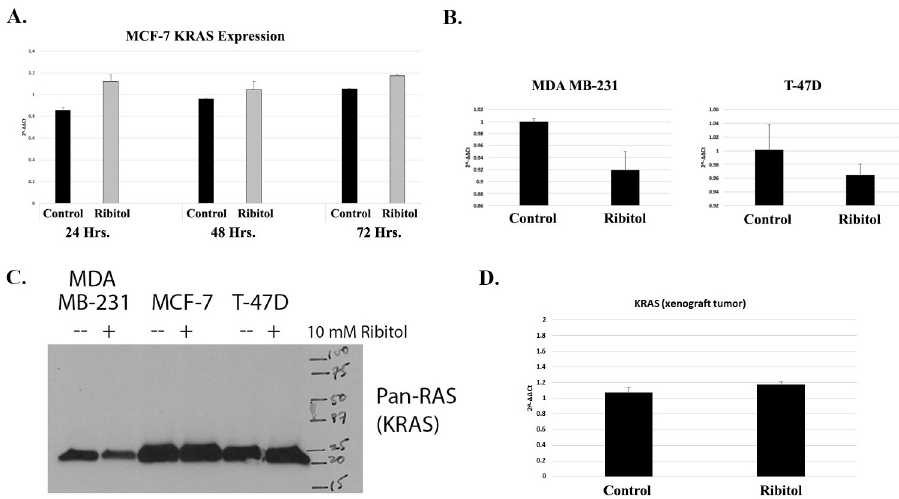
Fig 7. KRAS gene expression and protein levels in MCF-7, MDA MB-231, and T-47D breast cancer cells treated with ribitol. A) KRAS expression in MCF-7 cell line by Real-Time qRT-PCR B) Relative KRAS expression in MDA MB-231 and T-47D breast cancer cell lines by Real-Time qRT-PCR C) KRAS protein expression by western blot of control, and ribitol-treated breast cancer cell lines MDA MB-231, MCF-7, and T-47D (D) Relative KRAS expression in xenograft MCF-7 tumors after ribitol treatment by Real-Time qRT-PCR.